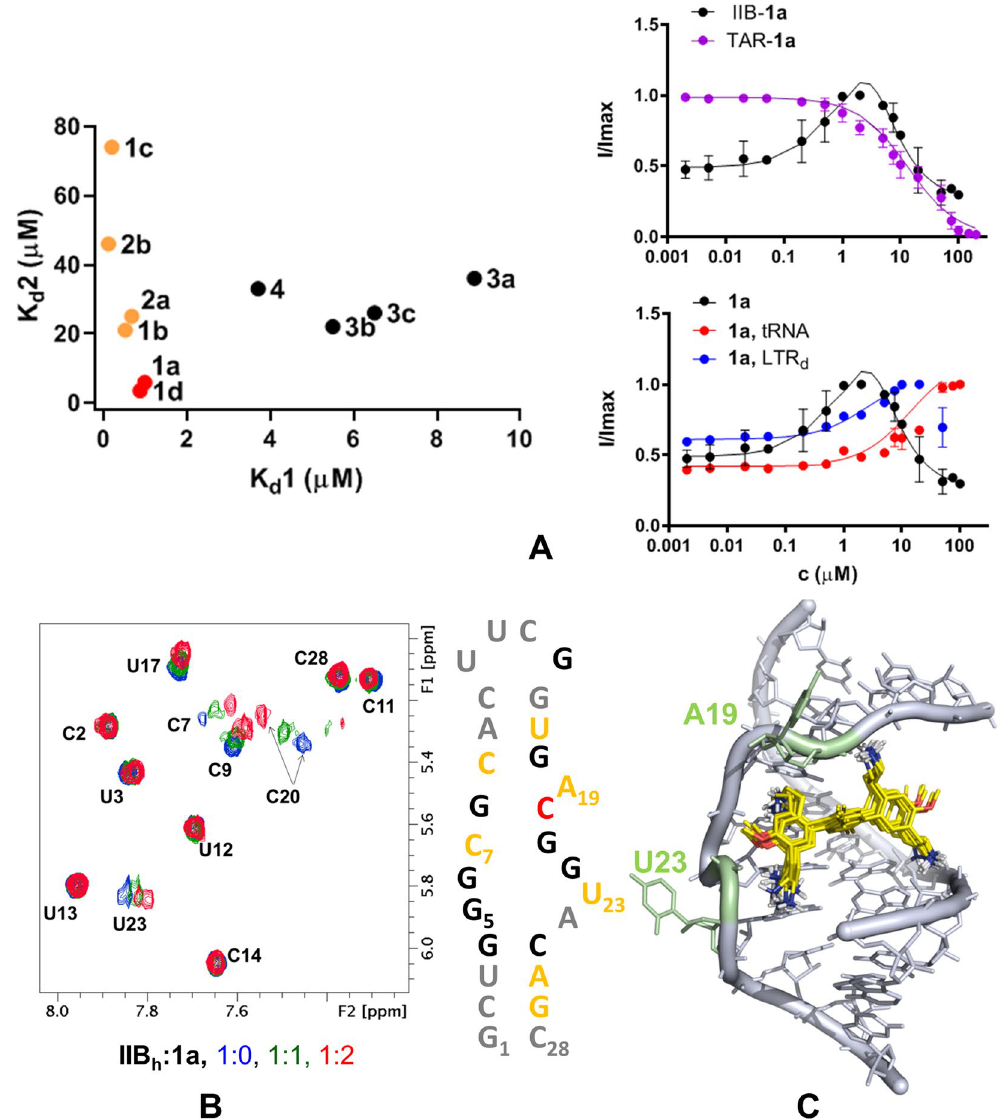
Figure 4. RRE subdomain IIB recognition by 1,4-terphenyl compounds. ( A ) Results of fluorescence intensity experiments. Left: comparison between first-site (K d 1) and second-site (K d 2) equilibrium dissociation constants for the interaction between IIB h and 1,4-terphenyl molecules. Right: comparison of the IIB h binding curve of terphenyl 1a (black) with the TAR h association curve (magenta), and with IIB h binding curves obtained in the presence of a 10-fold molar excess of unlabelled competitor RNA (tRNA Lys ; red) or unlabelled competitor double-helical DNA (LTR d ; blue). Solution conditions: 10 mM sodium phosphate pH 6.6 and 0.1 mM EDTA. ( B ) Titration of IIB h with terphenyl 1a monitored by NMR spectroscopy. The H5-H6 region of the TOCSY spectrum of unbound IIB h (blue) is superposed on the spectra of complexes with increasing RNA: 1a molar ratios, color-coded as indicated in the graph. A map of the 1a binding site in the IIB h hairpin is shown on the right. Nucleotides whose aromatic protons undergo chemical shift variations upon the addition of two equivalents of 1a are highlighted in orange and red ( Δδ ≥ 0.04 and 0.08 ppm, respectively). Nucleotides with overlapped aromatic resonances are black-coloured, and residues whose aromatic signals were not affected by ligand binding are coloured grey. Solution conditions: 10 mM sodium phosphate pH 6.0 and 0.1 mM EDTA. ( C ) Model of a 1:1 complex between RRE loop IIB and 1a (depicted with yellow carbon atoms), obtained from unrestrained docking calculations with the 4PMI PDB structure 12 . The image was generated with MOE 2019.0102 (www.chemcomp.com) and shows superimposed the converged docking poses of 1a